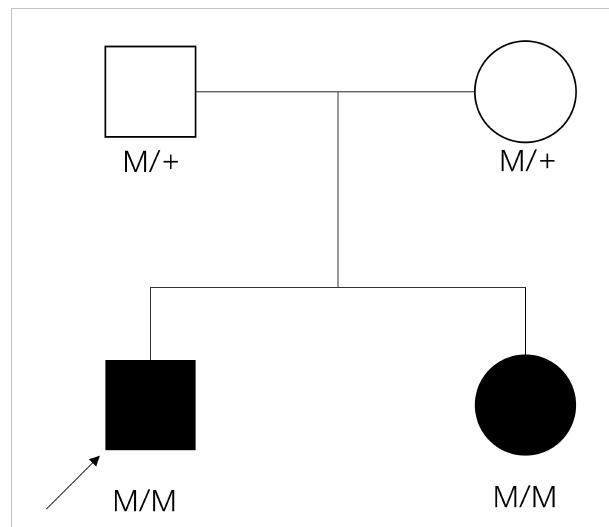
FIGURE 2 The pedigree of the family. Filled symbol: patient, un fi lled symbol: unaffected parents, black arrow: the proband, plus: normal allele, M: mutant